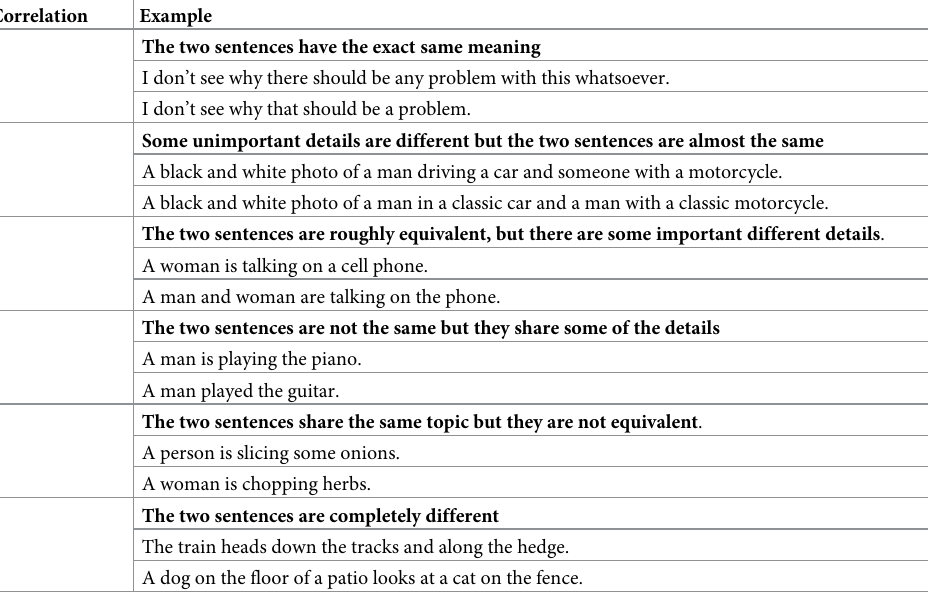
Table 1. Examples of different levels of correlation between the sentences in STS